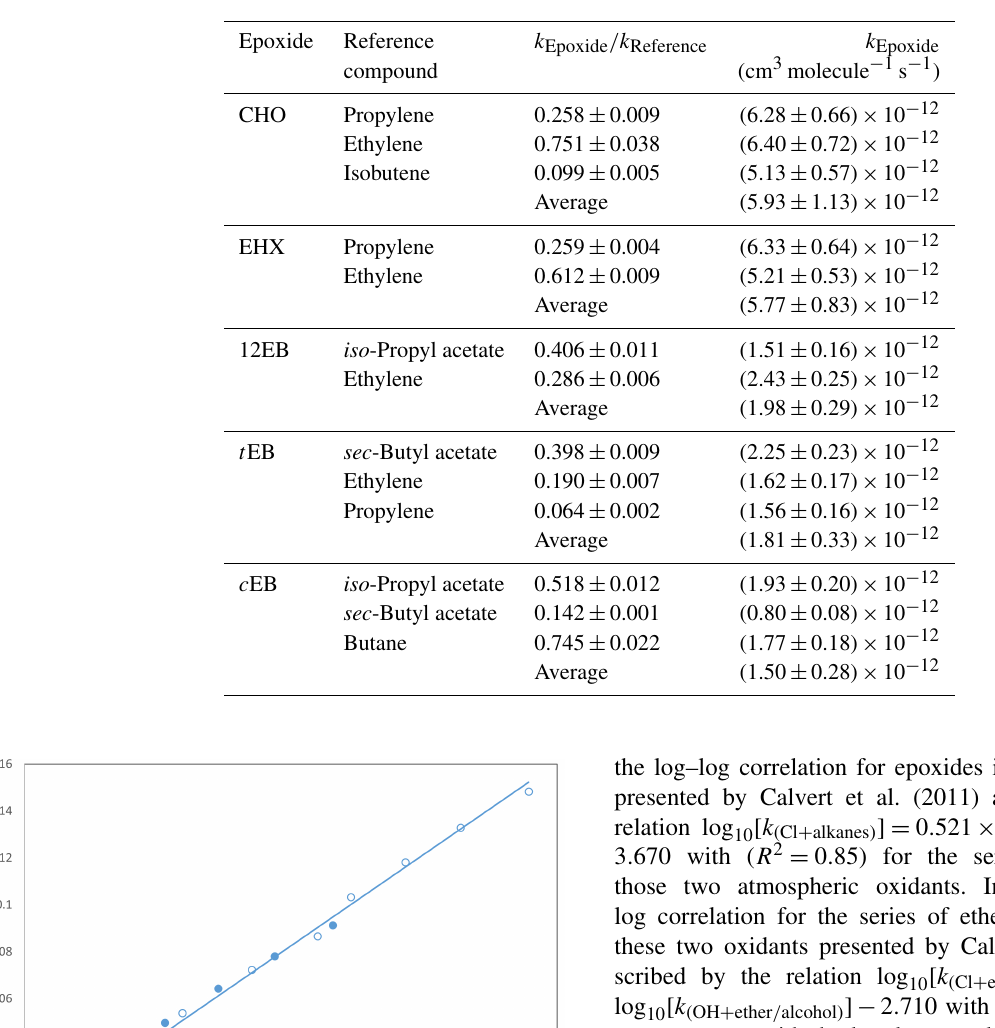
Table 2. Measured rate coefficient ratios, k Epoxide /k Reference , and the rate coefficients for the reactions of OH radical with epoxides at (298 ± 3)K derived from these ratios.